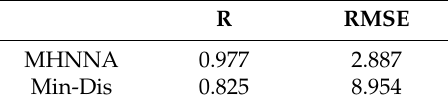
Table 7. Accuracy